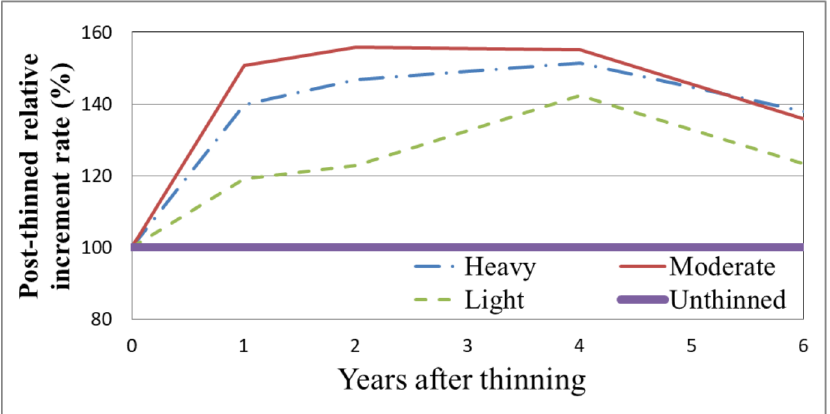
Figure 5. Percentage increases in the diameter at breast height (DBH) among different thinning treatments of Honduras mahogany in the Guanmiao Farm in Guanmiao, Taiwan after thinning relative to that of the un-thinned (relative increment of the un-thinned is